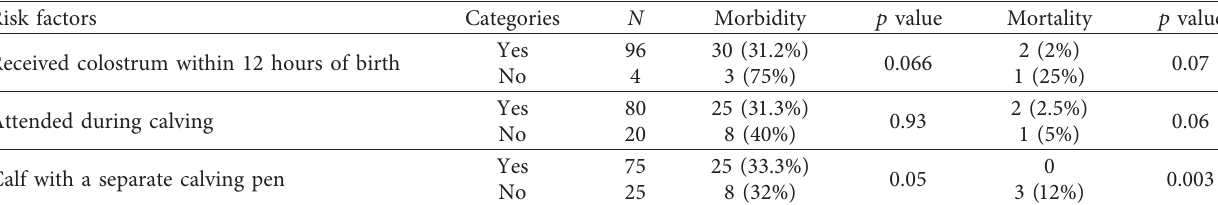
Table 5: Effect of periparturient calf management on morbidity and mortality of calves.